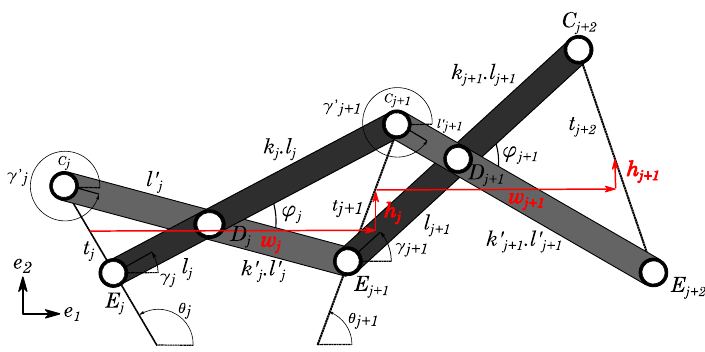
Figure 3. Geometric representation of a planar scissor-structural mechanism (SSM).